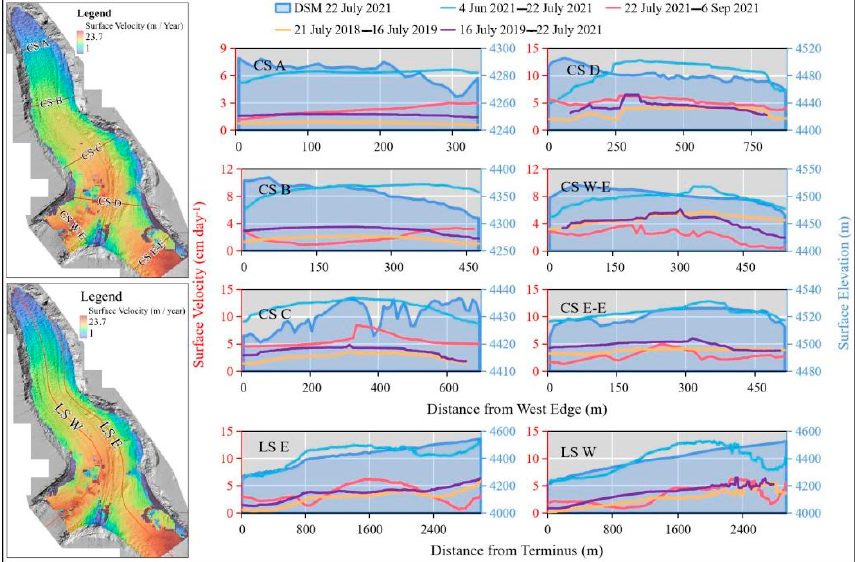
Figure 7. Seasonal surface velocity of LHG12 at cross and longitude profiles.